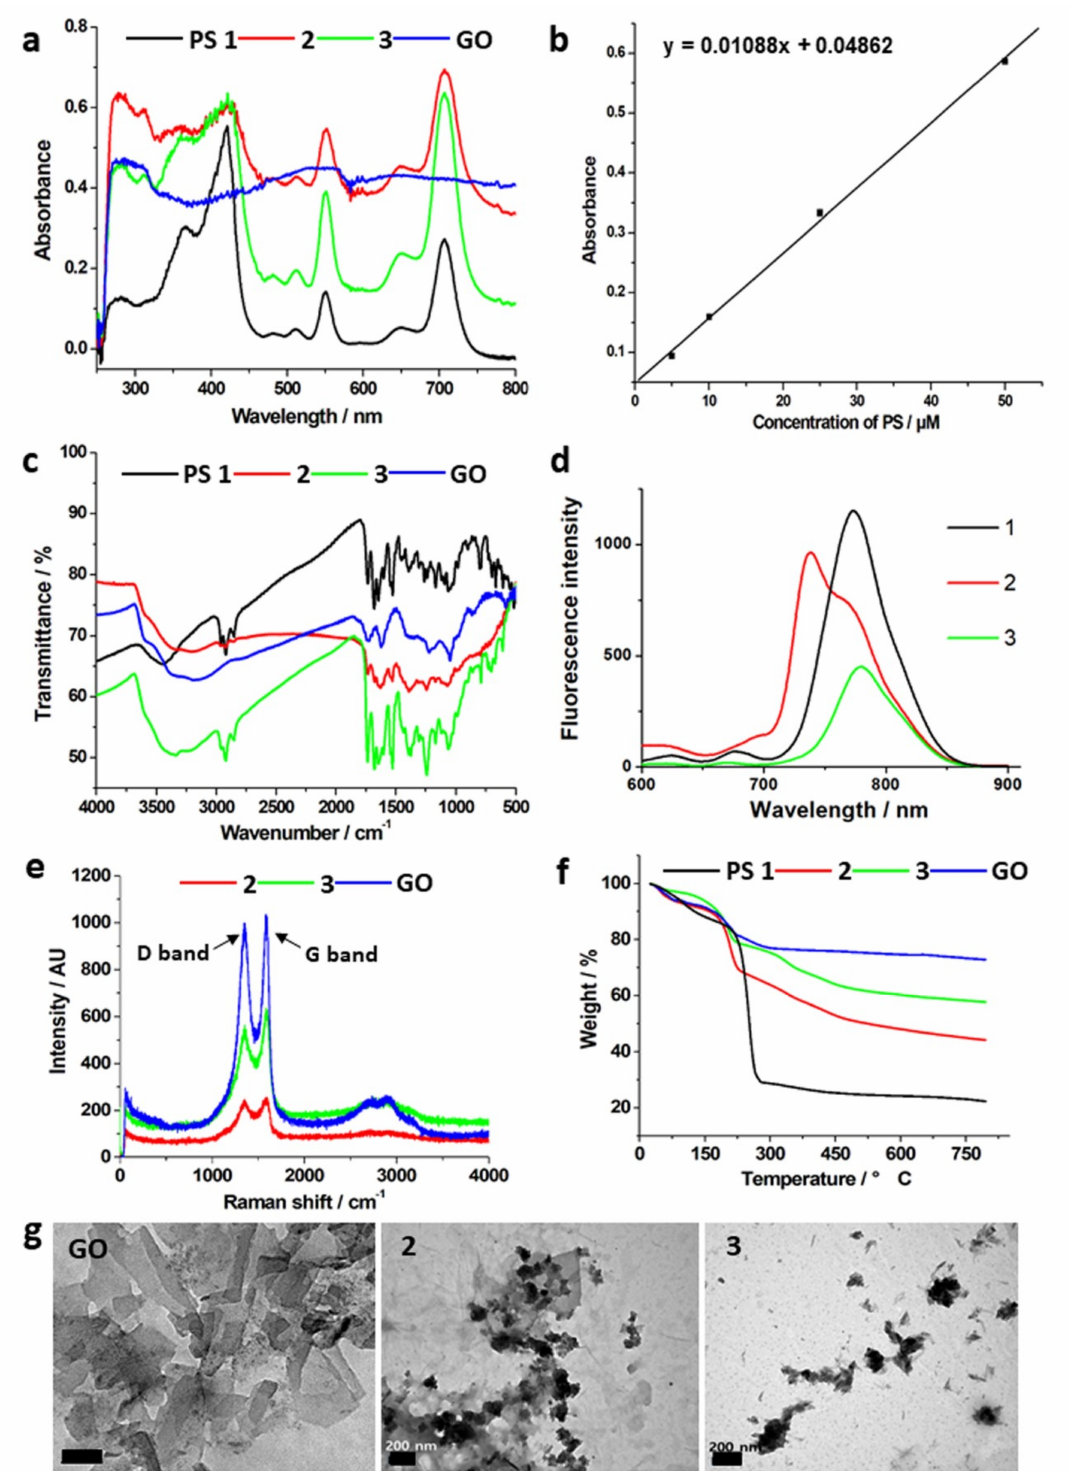
Figure 1. Characterisation of PS 1 , and GO–PS complexes 2 and 3 : ( a ) UV-VIS absorbance spectra of 1 , 2 , 3 and GO (dimethyl sulfoxide (DMSO)); ( b ) UV-VIS absorbance standard curve of 1 at 707 nm (DMSO), R 2 = 0.99903; ( c ) FT-IR spectra of 1 – 3 and GO (KBr); ( d ) Fluorescence emission spectra of 1 – 3 , excitation wavelength was 530 nm; ( e ) Raman spectra of 2 , 3 , and GO; ( f ) thermogravimetric analysis (TGA) graph of 2 , 3 , and GO; ( g ) transmission electron microscopy (TEM) images of GO, 2, and 3 (scale bar 100 nm for GO, and 200 nm for 2 and 3